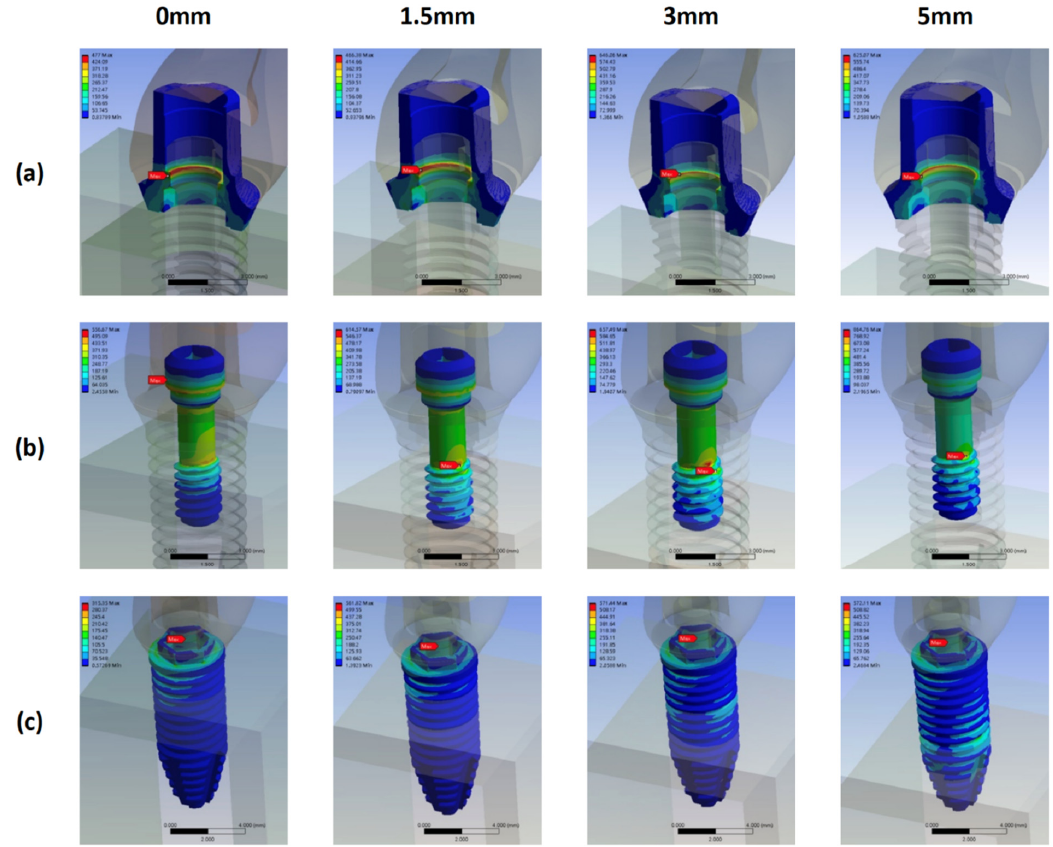
Figure 9. Stress distribution and maximum von Mises stress on the abutment, screw, and fixture in the ST groups with different bone loss levels. ( a ) abutment ( b ) screw ( c ) fixture. The location of the maximum stress on the screw moved apically with bone loss, from the implant head–neck connection region with no (0 mm) bone loss to the shank–thread connection region with any amount of bone loss. The magnitude of the stress increased stably with bone loss progression and sharply increased by 31.6%, from model ST3 (657.49 MPa) to model ST5 (864.76 MPa). The location of the maximum stress on the fixture remained unchanged with bone loss progression: coronal border of the first tread of the fixture. The magnitude of the stress increased significantly from model ST0 (315.35 MPa) to model ST1.5 (561.82 MPa); it remained constant even with further bone loss. The location of the maximum stress on the abutment remained almost unchanged with bone loss progression: the screw head–abutment contact region. The magnitude of the stress was 38.5% higher in model ST3 (646.06 MPa) than in model ST1.5 (466.38 MPa); however, this magnitude decreased to 625.07 MPa in model ST5. In other words, the high- est stress on the abutment was noted in model ST3. Finally, the ST3 model led to the highest stress on the bone. 3.3. Stress Distribution Pattern of Each CT Model Component with Different Bone Loss Levels